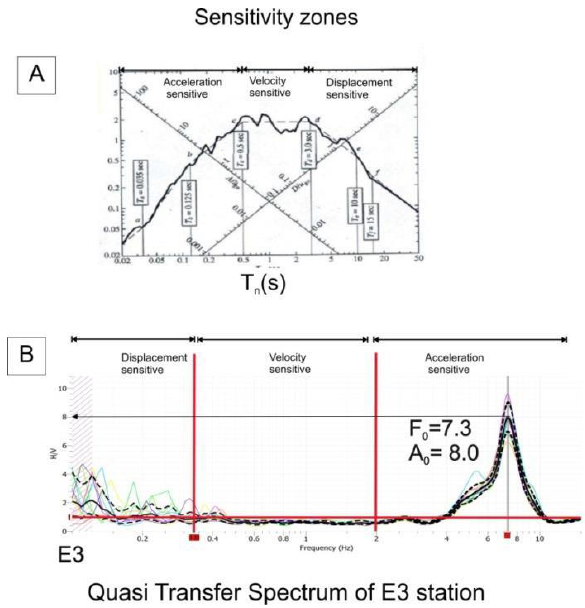
Figure 4. Determination of the sensitivity zones. A) Three